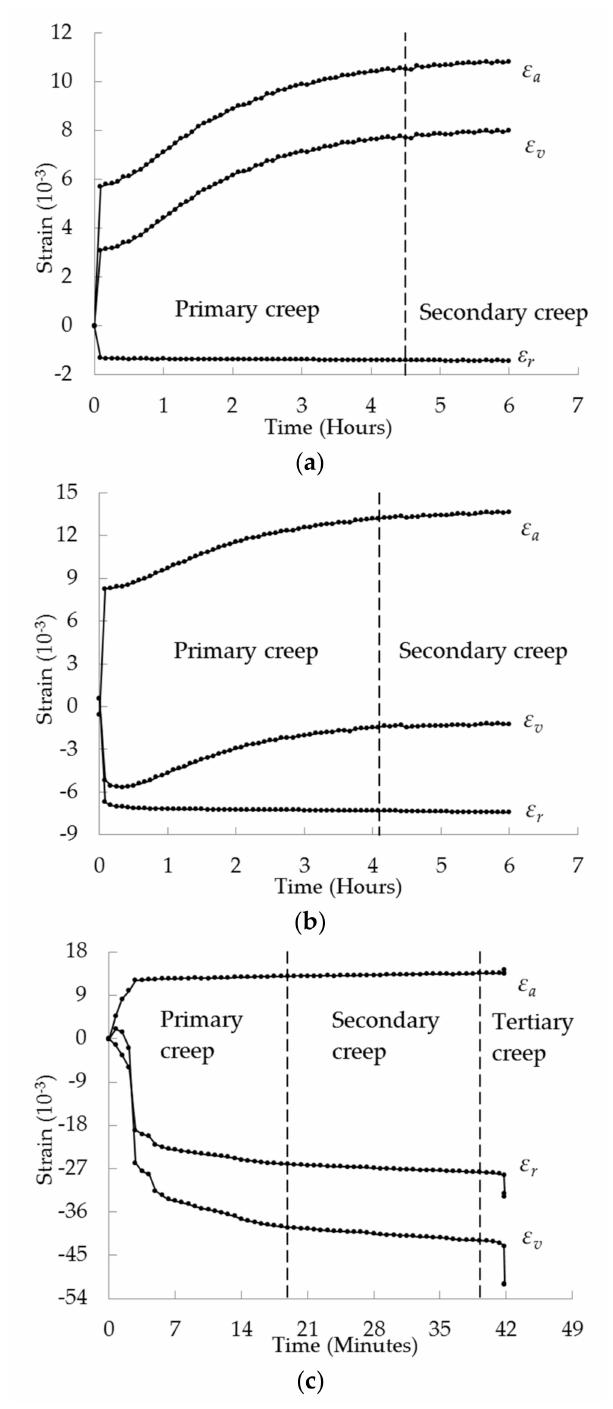
Figure 4. Creep curves for coal sample compressed at: ( a ) 8.03 MPa; ( b ) 17.01 MPa; ( c ) 11.02 MPa (dashlines denote the transition points of creep